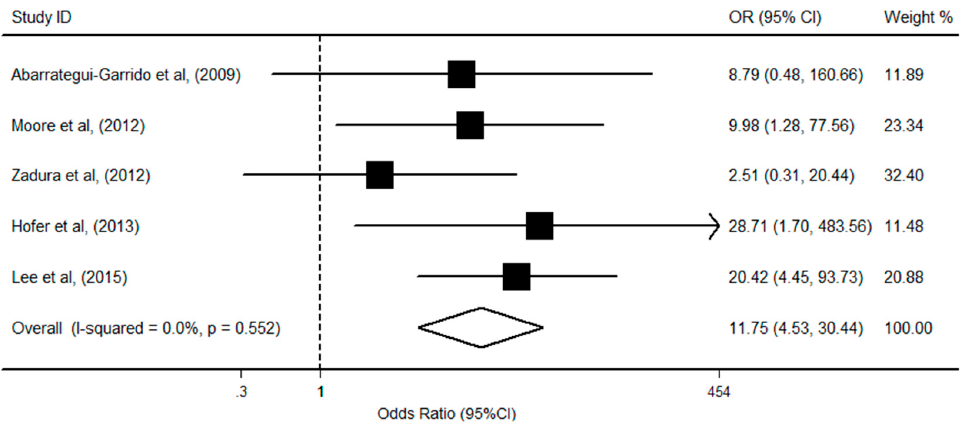
Figure 4. Forest plot on the association among CFHR1 deficiency, anti-FH autoantibodies, and aHUS risk. For each study, the estimation of OR and its 95% CI are plotted with a box and a horizontal line. The pooled odds ratio is represented by a diamond. The area of the black squares reflects the weight of the study in the meta-analysis.